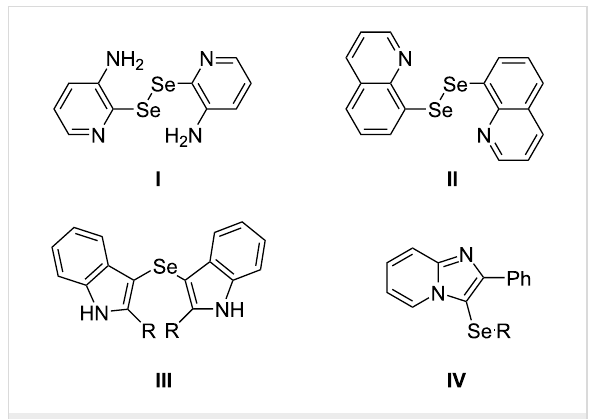
Figure 1: Biologically active selenides and diselenides having heteroaryl